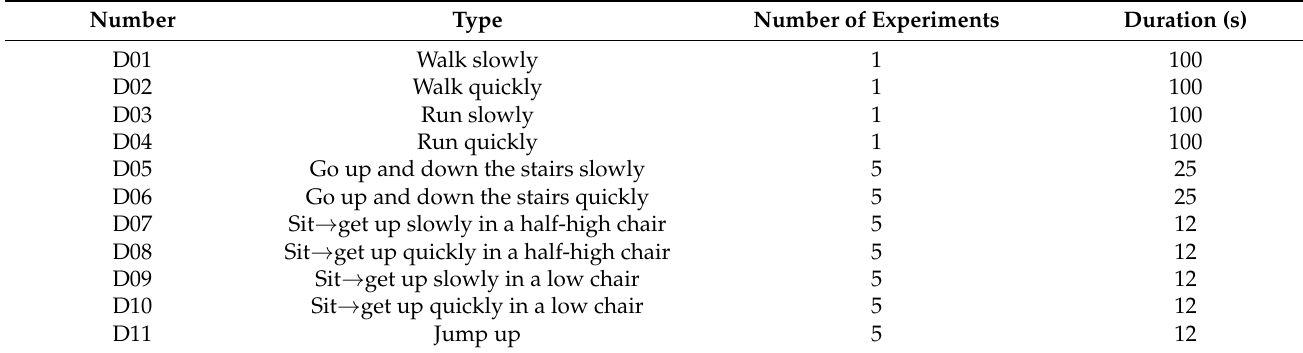
Table 1. Types of